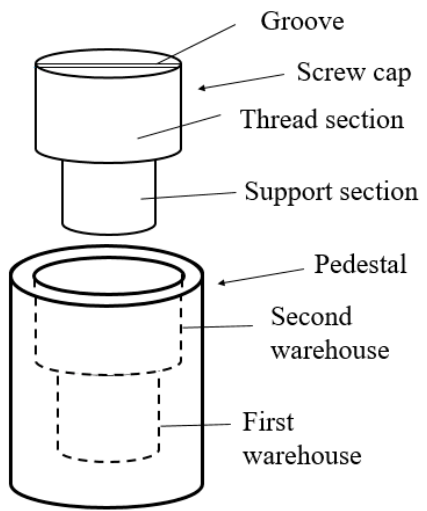
Figure 2. The schematic of recovery capsule [18].